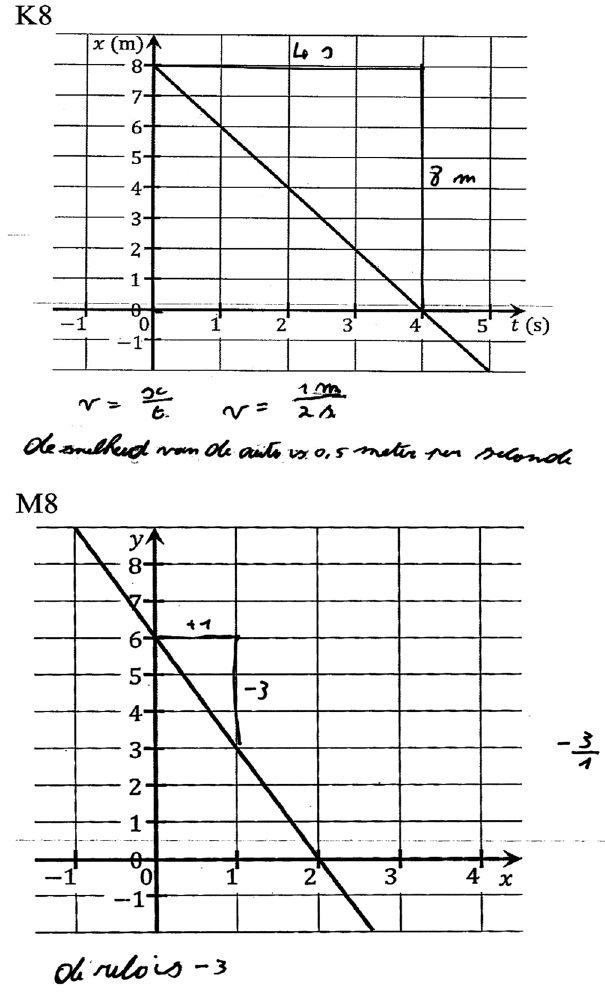
FIG. 13. Example of isomorphic questions K8 and M8 solved by the same student. In both cases strategy S7 is used, but in kinematics the minus sign has not been taken into account in contrast to M8. Translated wording in K8 and M8 are “ The speed or velocity of the car is 0.5 meters per second. ” and “ The slope is -3.